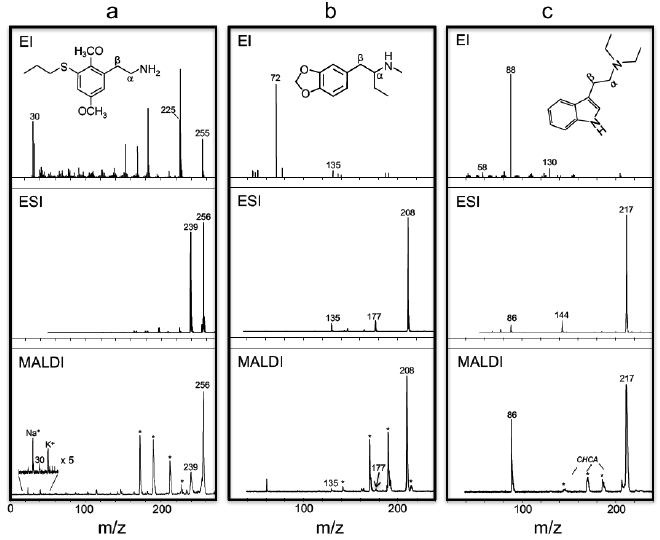
Figure 3. EI/MS; ESI/MS; and MALDI/TOFMS spectra of ( a ) 2C-T-7, ( b ) 3,4-MBMB and ( c ) DET (each sample, 0.1 mg mL − 1 methanol), respectively. The major fragments of CHCA are indicated as “*”.